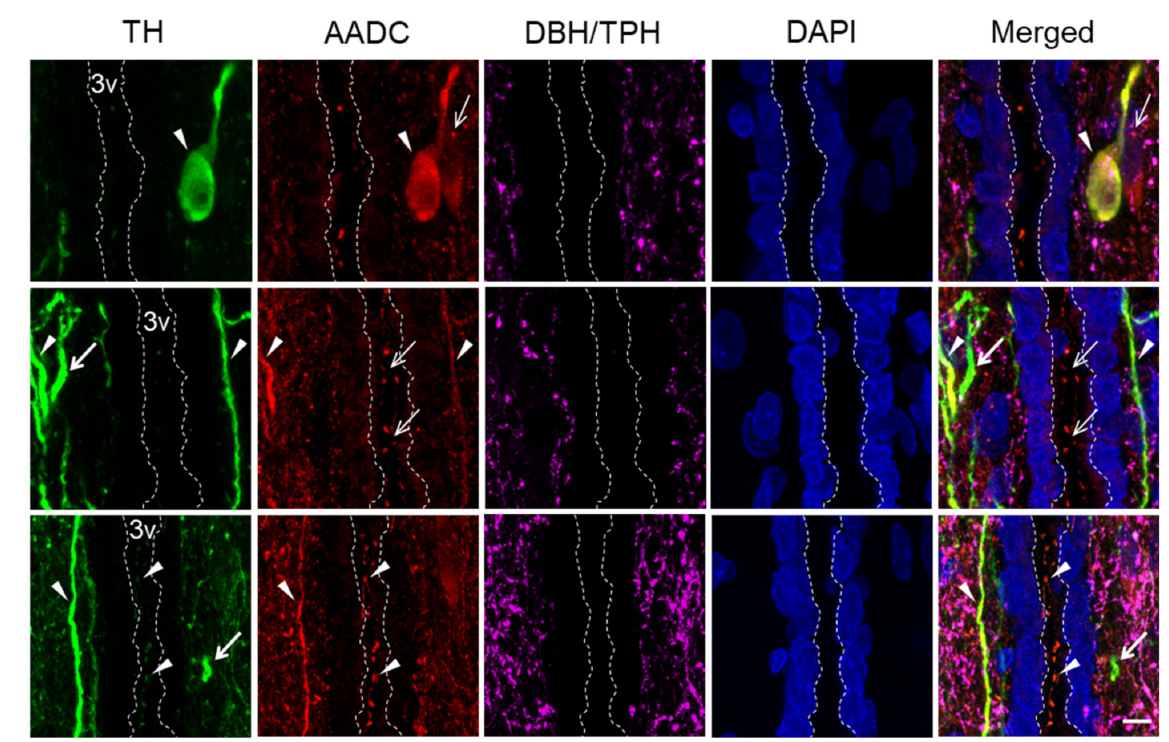
Figure 5. Observations in a confocal microscope of the topographic relations of neurons (cell bodies) and fibers, immunopositive only for tyrosine hydroxylase (TH+, green, thick arrow), only for aromatic amino acid decarboxylase (DAA+, red, thin arrow), for both enzymes (TH+/DAA+, yellow, arrow head), as well as nerve fibers immunopositive for tryptophan hydroxylase (TPH) and/or dopamine- β -hydroxylase (DBH) (purple, closed arrow) within the 3rd ventricle. All types of neurons and fibers are located in the subependymal zone, whereas some fibers, immunopositive for both enzymes or only for AADC, are seen between the ependymal cells and in the 3rd ventricle. Scale: 5 µ m; × 63. 3v, third ventricle; dotted line, apical surface of the ependymal lining facing the cerebrospinal fluid.